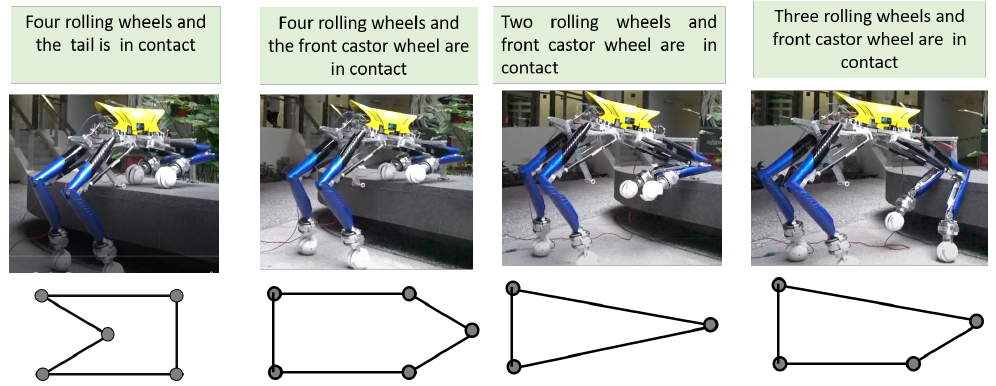
Figure 10. The support polygon for different gates of the platform during level shifting.